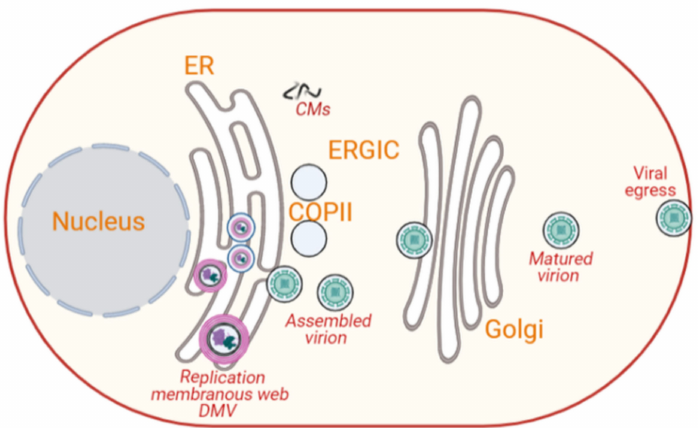
Figure 4. Intracellular membrane rearrangements induced by flaviviruses. Flaviviruses, such as HCV, lead to production of DMVs through the curvature of the ER membrane. These DMVs are embedded into a membranous web and carry non-structural proteins, and they are positive for dsRNA. Flaviviruses assemble close to the ER and acquire their envelope by budding into ER, and they usurp specific ER functions, such as the membrane trafficking apparatus, for their intracellular trafficking to the plasma membrane via the Golgi for final exit (image created in